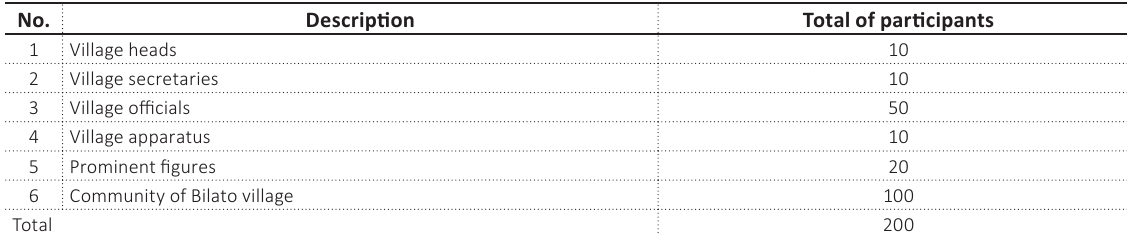
Table 1. Instrument